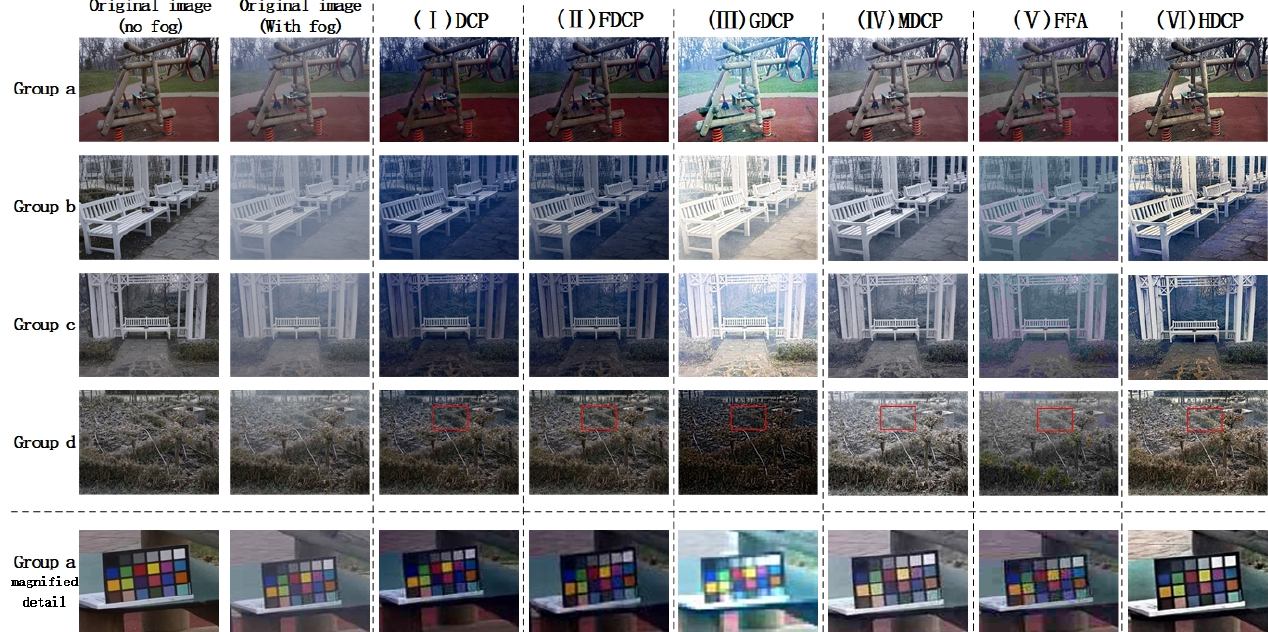
Figure 4. Comparison of example pictures in the O-HAZE dataset. The processing results are, re- spectively, from: ( Ⅰ ): DCP [20], ( Ⅱ ): FDCP [26], ( Ⅲ ): GDCP [27], ( Ⅳ ): MDCP [15], ( Ⅴ ): FFA [19], and respectively, from: (I): DCP [20], (II): FDCP [26], (III): GDCP [27], (IV): MDCP [15], (V): FFA [19], and ( Ⅵ ): HDCP. The last row is the enlarged result of group a’s color card. (VI): HDCP. The last row is the enlarged result of group a’s color